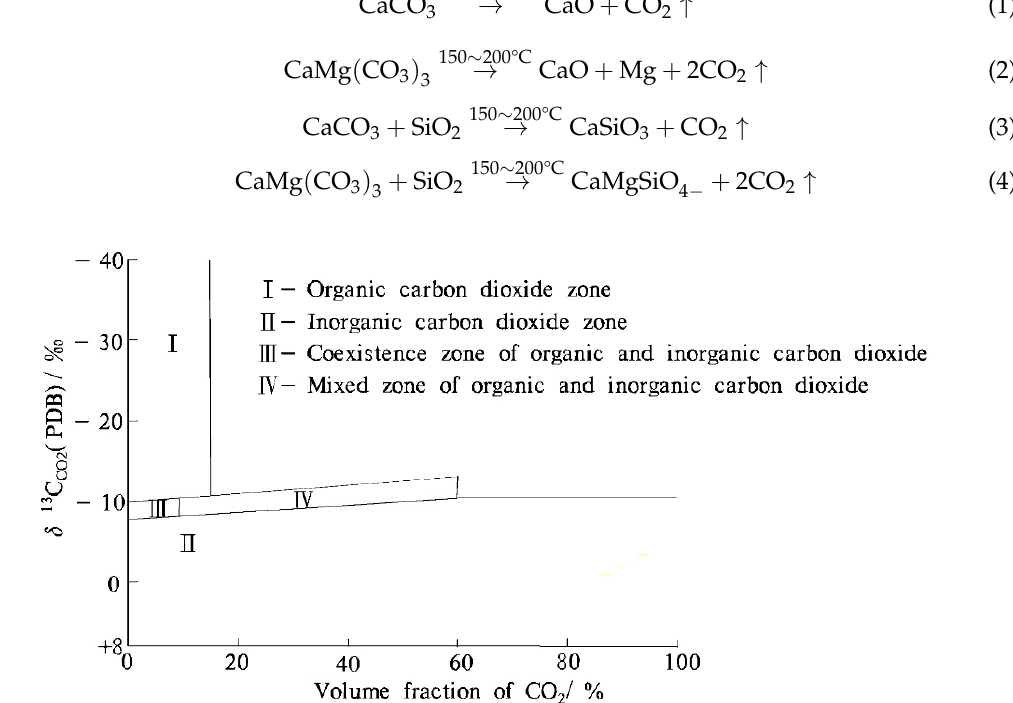
Figure 5. Identification chart of carbon dioxide origin in Xining Basin (according to [41]).